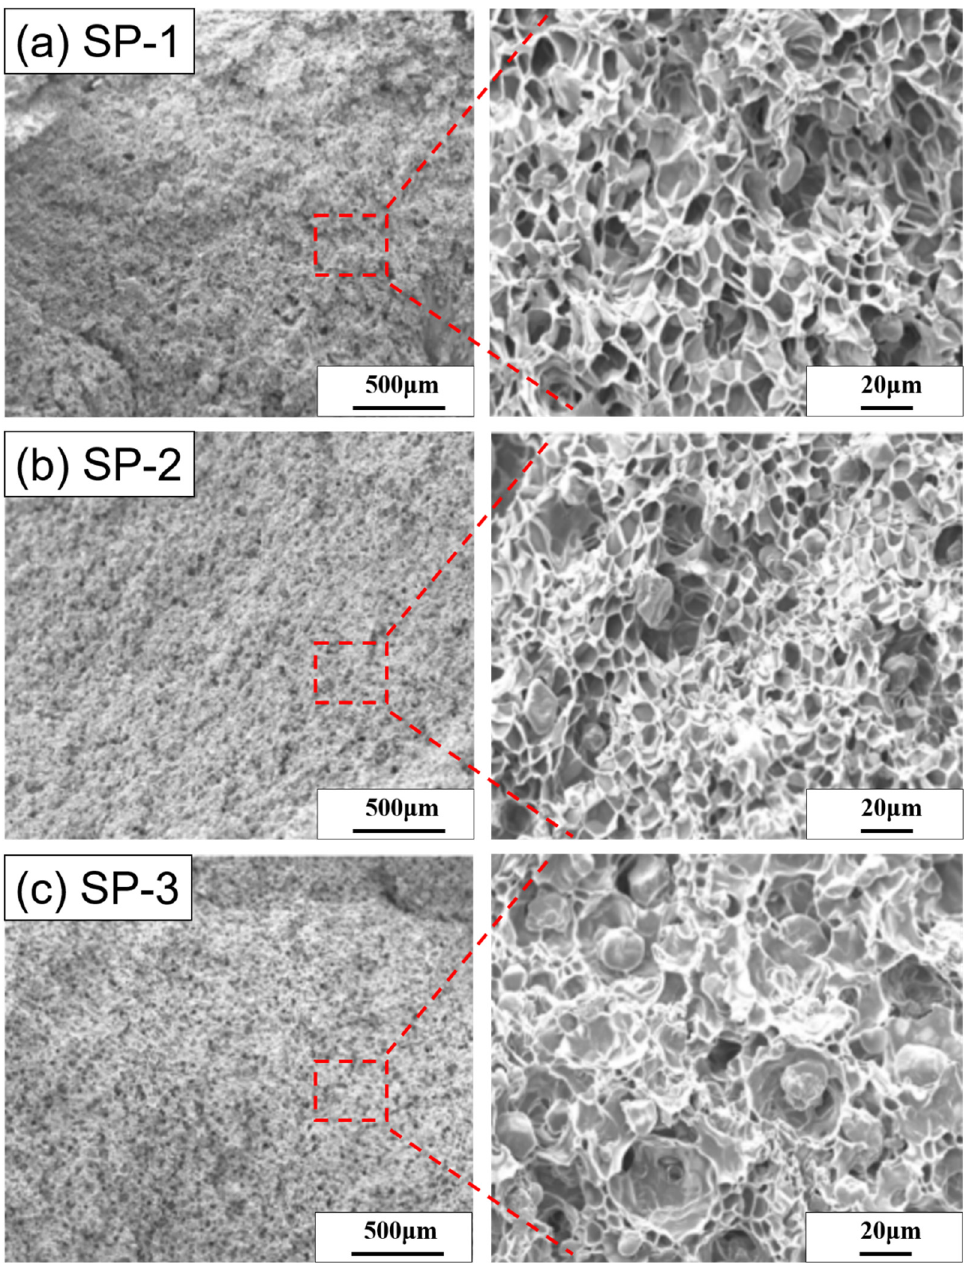
Figure 4. SEM images of cell structure at the foaming temperature of 95 °C and the foaming pressure of 17 MPa. ( a ) [SP-1], ( b ) [SP-2], and ( c ) [SP-3].